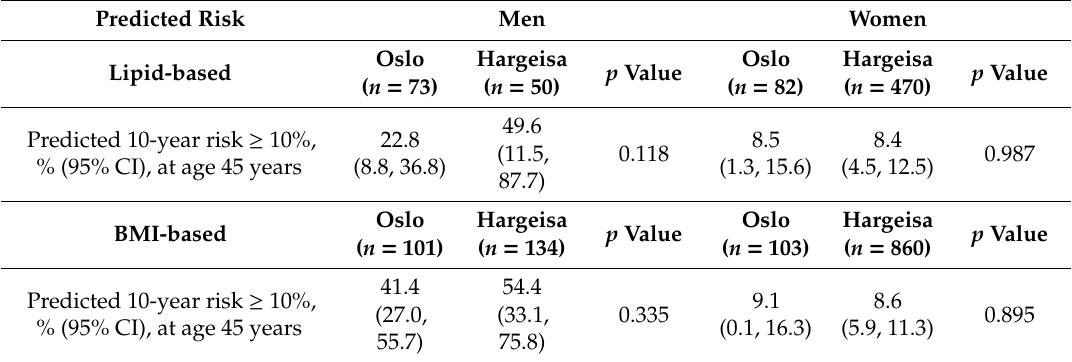
Table 4. Predicted 10-year cardiovascular disease (CVD) risk of ≥ 10% using the Framingham risk scores based on lipids and BMI, age adjusted.